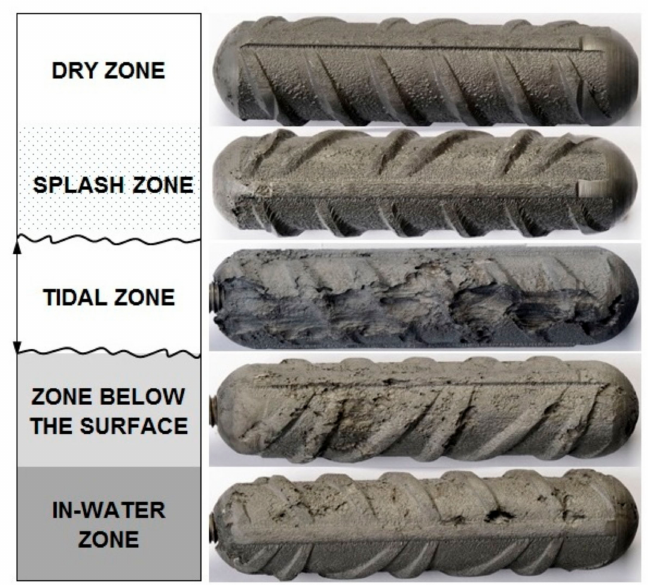
Figure 6. Photographs of the corrosion damage on the carbon steel-coupled multi-electrodes after extraction from the column C11.